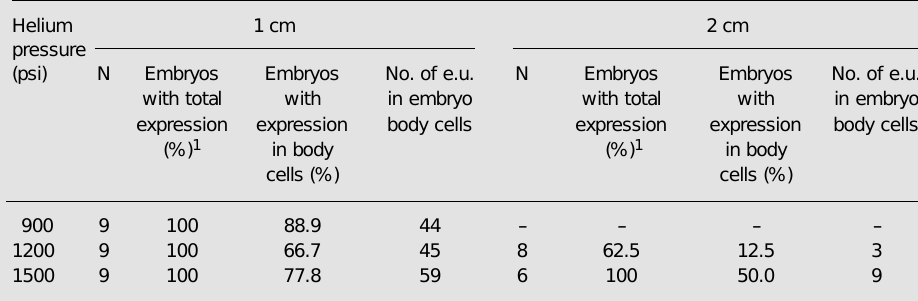
1 Embryos with ß-gal expression in body cells or extra-embryonic tissue or both. DNA-coated microparticle flying distance to the embryo was 8 cm. e.u. = expression